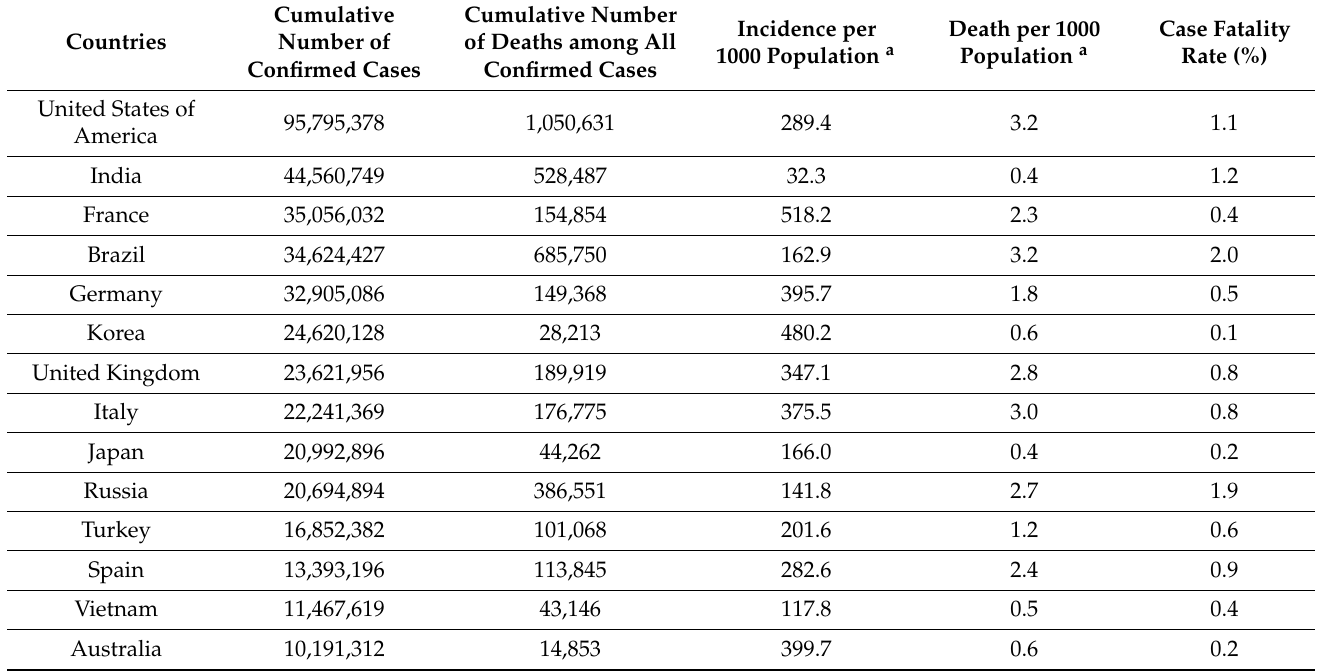
Table 1. Global epidemiology of COVID-19 in terms of countries with a cumulative number of confirmed cases of more than 10 million as of 25 September 2022 (day 1000).